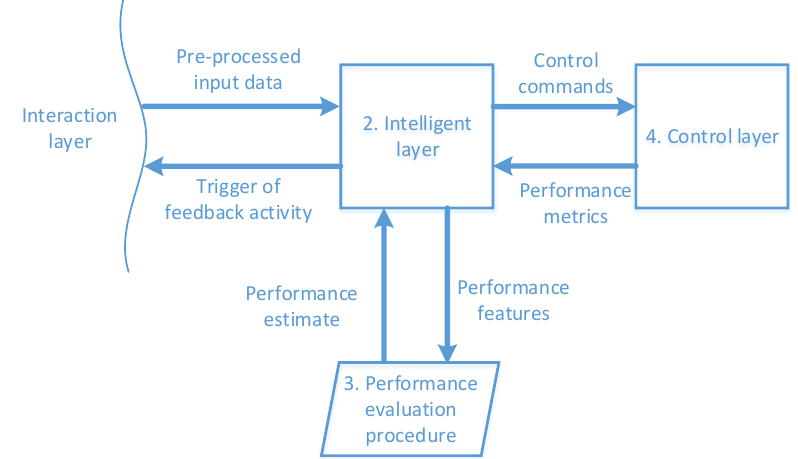
Figure 4. Communication between the intelligent layer and other components of HA-HCI.